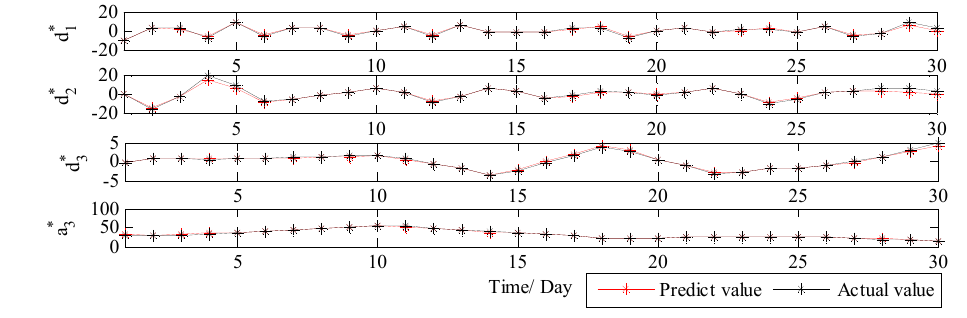
Figure 11. The forecast results of each subset using WT-VMD-DE-BP (Wuhan). Table 1. Forecast errors of WT-DE-BP and WT-VMD-DE-BP for each subset.